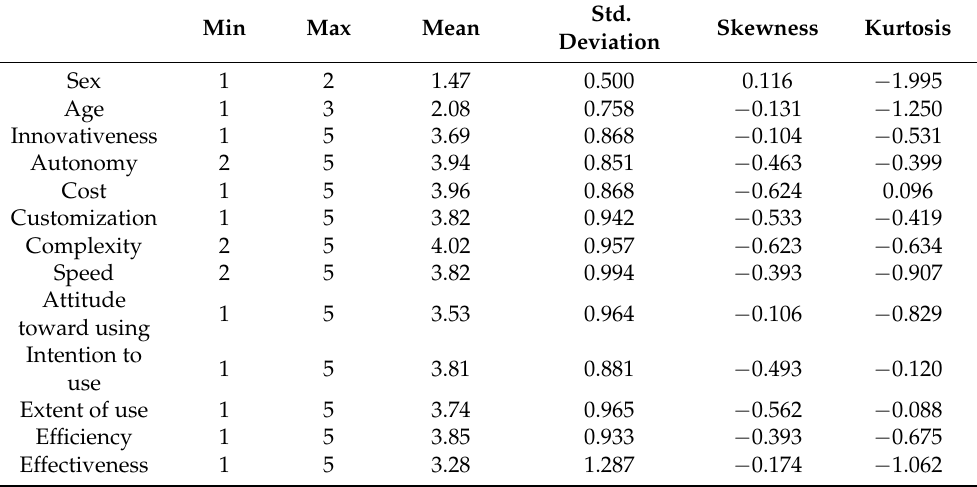
Table 2. Descriptive